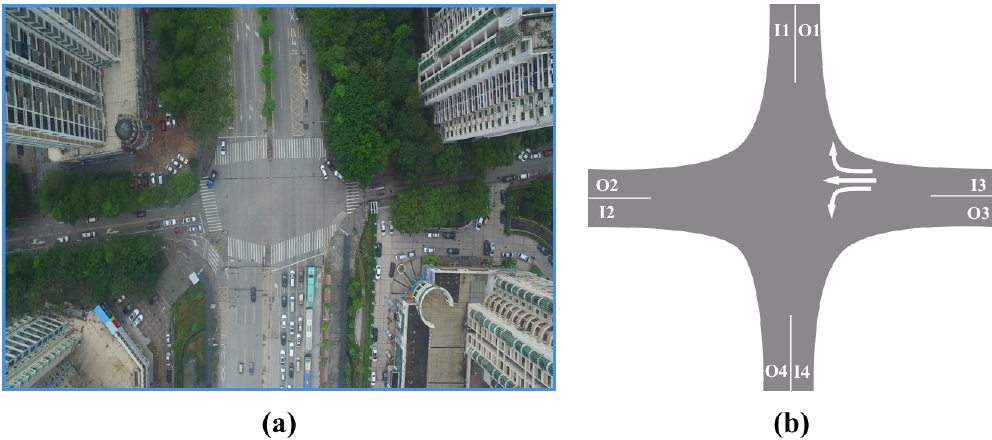
Figure 7. The traffic scene of the testing video. ( a ) The snapshot of the original video. ( b ) The sketch map of the intersection. The character “I” means “into the camera view” and the “O” means “out of the camera